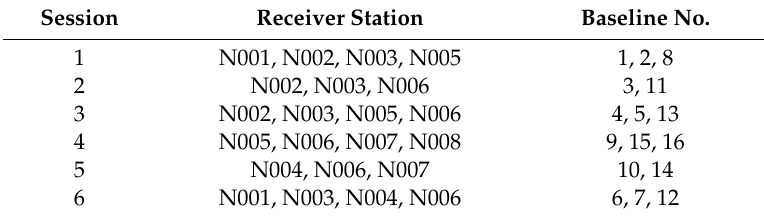
Table 5. Session arrangement for the observation of 16 baselines in the network by 4 GNSS receivers. Session